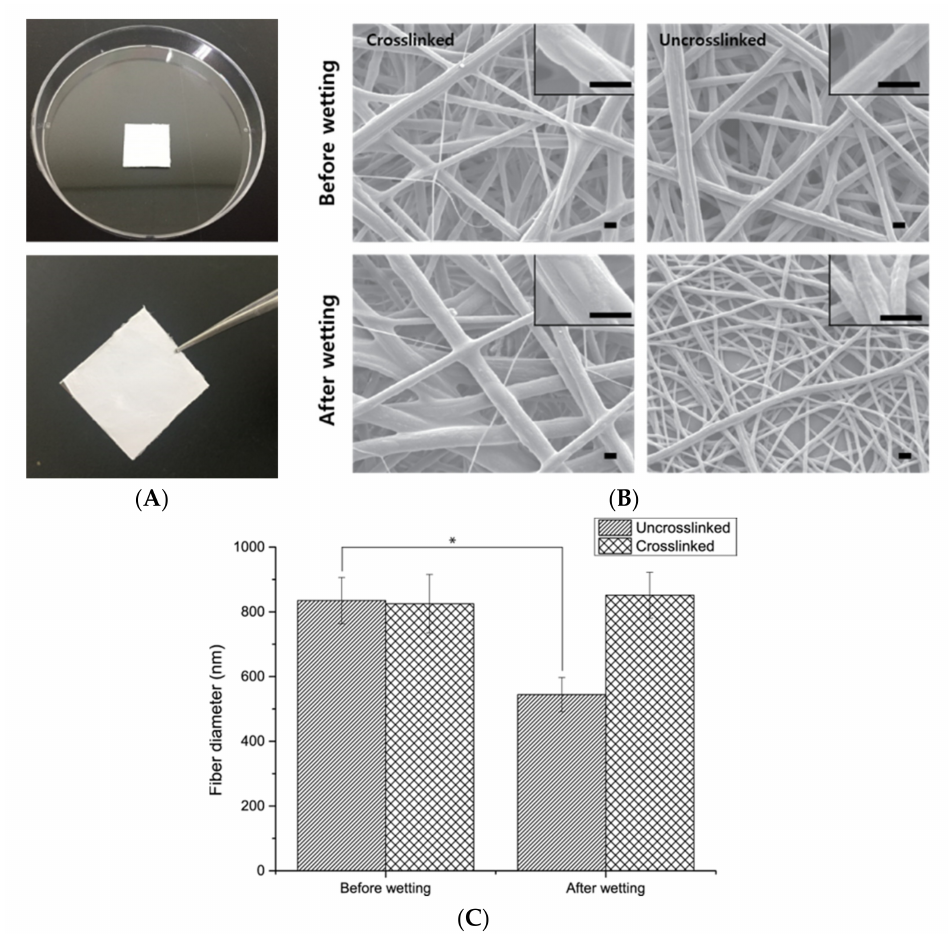
Figure 2. Characterization of the PCL/gelatin nanofibrous scaffolds. ( A ) Representative photographs of the scaffolds; ( B ) Representative SEM images of the scaffolds before and after wetting process. Scale bars 1 µ m for low and high magnifications; ( C ) The diameter of the PCL/gelatin nanofibers before and after wetting process. One-way ANOVA; Tukey’s post hoc test; * compared to each group; * p <